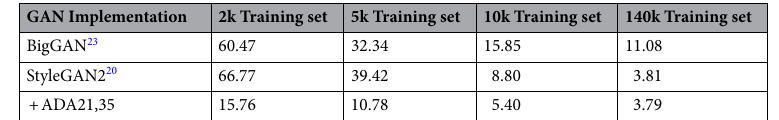
Table 2. Comparison of Fréchet Inception Distance (FID) scores of images generated at 256 × 256 for different dataset sizes from the Flickr Faces HQ Dataset (FFHQ) using StyleGAN2 with BigGAN, and the StyleGAN2 + ADA. Adapted from the StyleGAN2 + ADA original paper 21 .